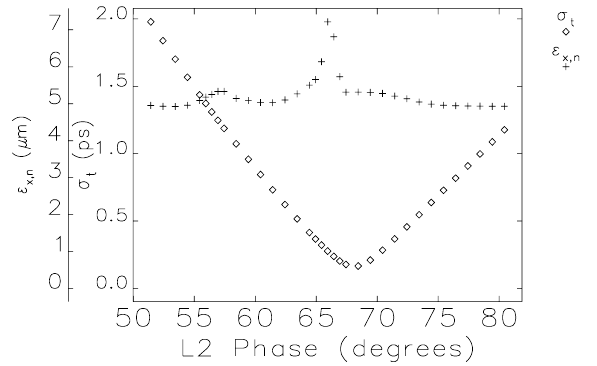
FIG. 5. Horizontal normalized emittance and rms bunch length versus precompressor linac phase.